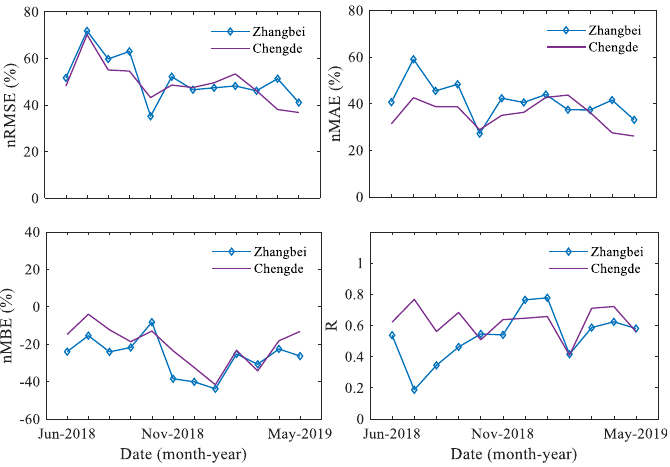
Figure 6. Monthly trend chart of the estimated DNI.